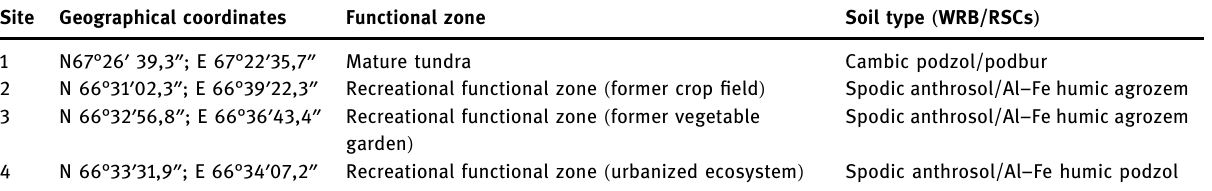
Table 1: The main characteristics of investigated sites Site Geographical